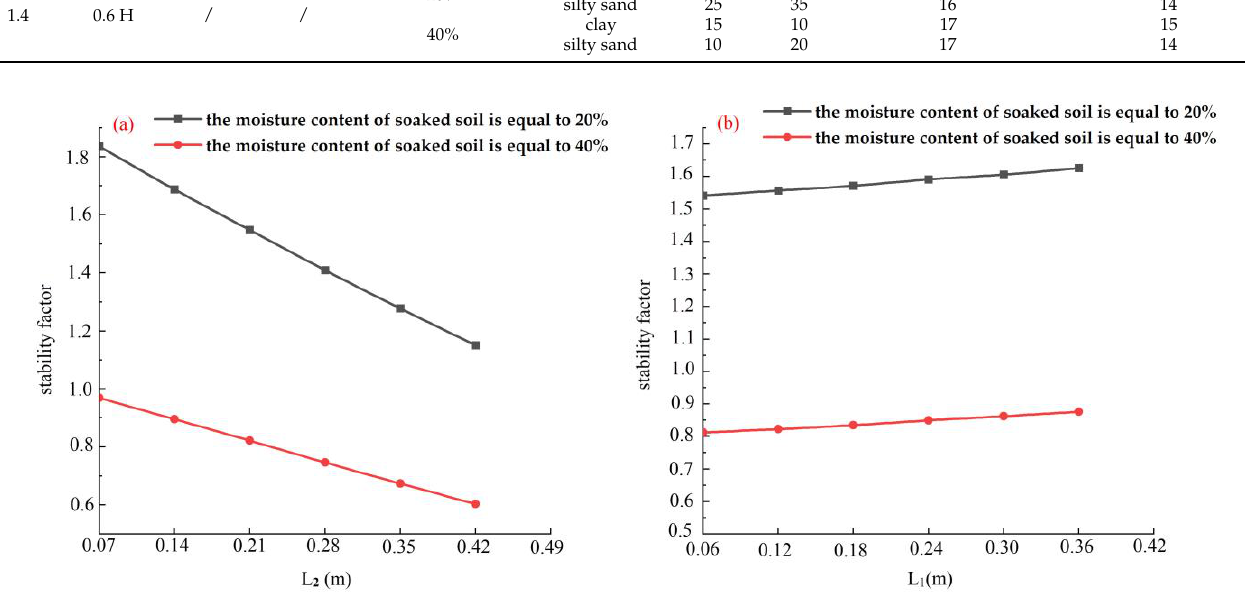
Figure 11. The effect of the scour degree on the bank stability: ( a ) the influence of the scour width on the stability coefficient; and ( b ) the effect of the scour height on the stability coefficient.